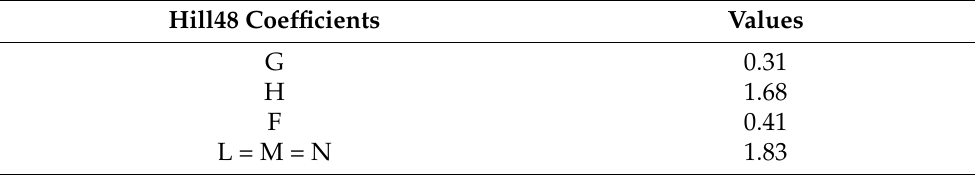
Table 6. Coefficients of Hill48’s anisotropic criterion for Grade 2 α